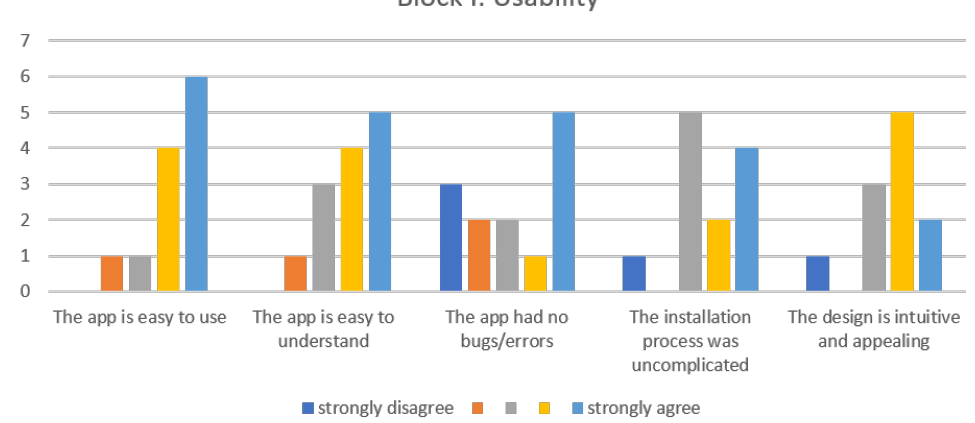
Figure 19. First set of questions regarding the usability of OpenLBar.